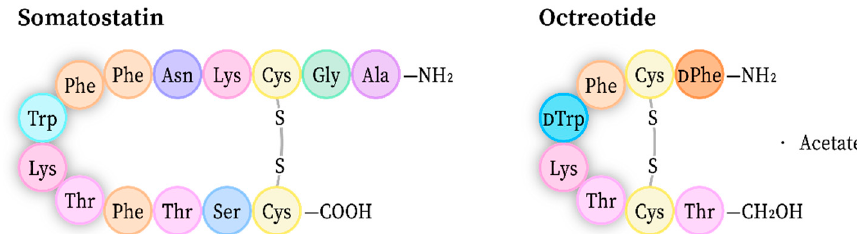
Figure 14. Comparison of amino acid sequences of somatostatin-14 and octreotide. The amino acids necessary for binding to the receptor are shadowed [155].